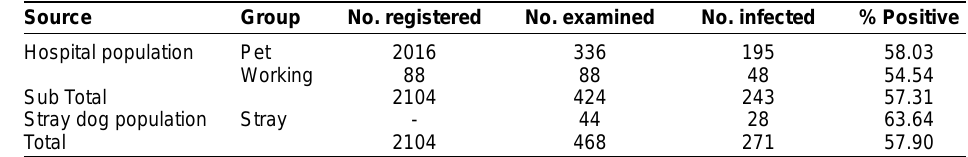
Table-1. Prevalence of haemoparasites in hospital and stray dog population Source